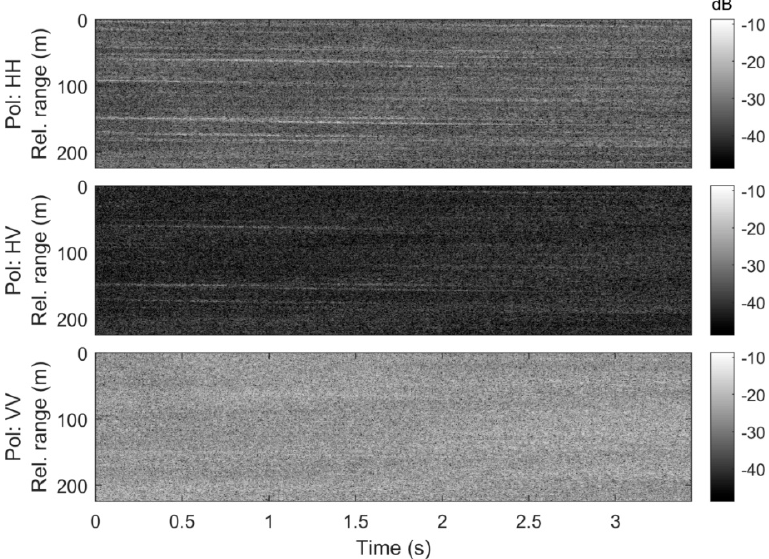
Figure 5. INGARA range/time example (Run 3), downwind, grazing angle 30°, wind speed 10.3 m/s.